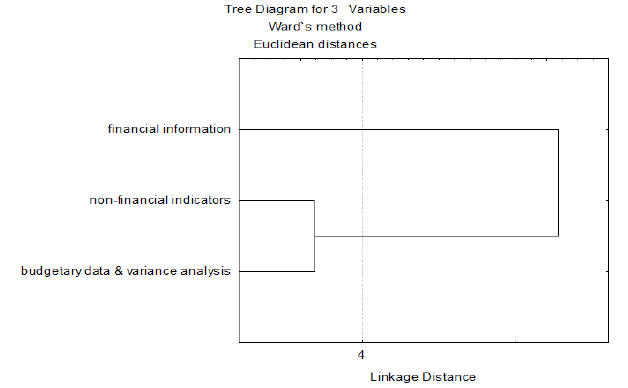
Fig. 6. The assessed suitability of selected management accounting information in Romania